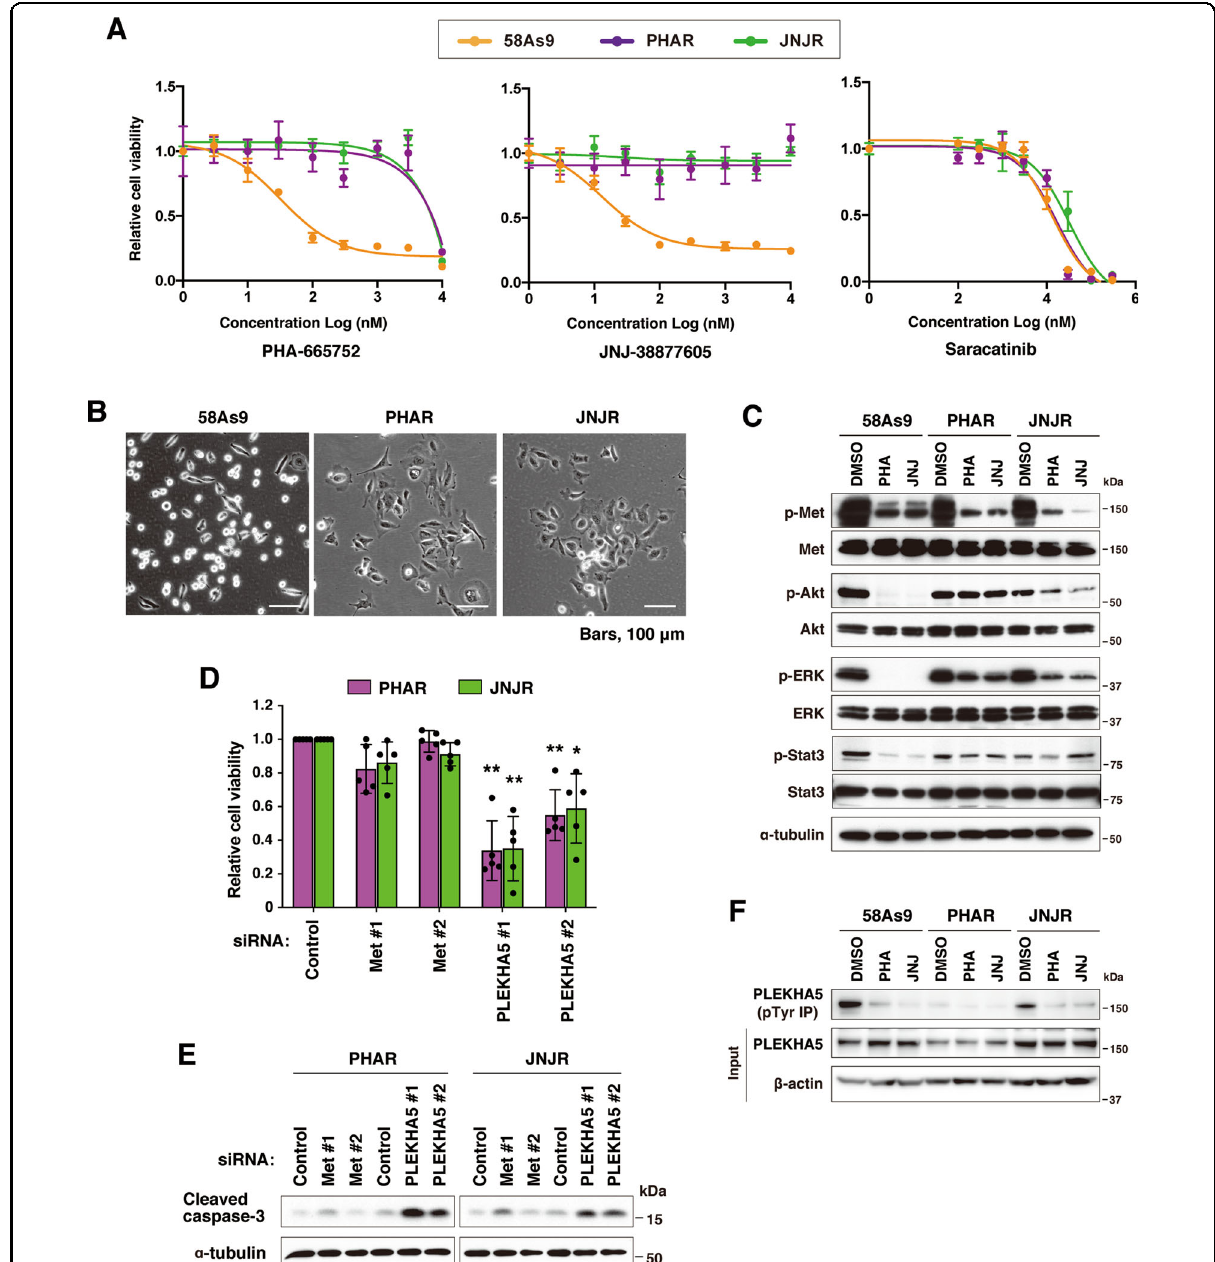
Fig. 4 PLEKHA5 knockdown suppressed the growth of Met-inhibitor-resistant DGC cells. A Met-inhibitor-resistant 58As9 cells, PHAR and JNJR, were established by continuously culturing 58As9 cells in the presence of PHA-665752 and JNJ-38877605, respectively. The cells were then treated with increasing concentrations of Met inhibitors or an Src inhibitor, saracatinib, and their viability was examined. Bars, SD ( n = 4). B Phase-contrast images show the morphology of 58As9, PHAR, and JNJR cells. C Immunoblot analysis of cells treated with PHA-665752 (PHA) and JNJ-38877605 (JNJ) at 300 nM for 2 h. D PHAR and JNJR cells were transfected with Met or PLEKHA5 siRNA and their viability was examined. Bars, SD ( n = 5). * P < 0.05; and ** P < 0.005. E The level of cleaved caspase-3 in PHAR and JNJR cells transfected with the indicated siRNAs was examined by immunoblotting. F Phosphorylation status of PLEKHA5 in PHAR and JNJR cells treated with Met inhibitors as in C was determined by immunoprecipitation and immunoblot